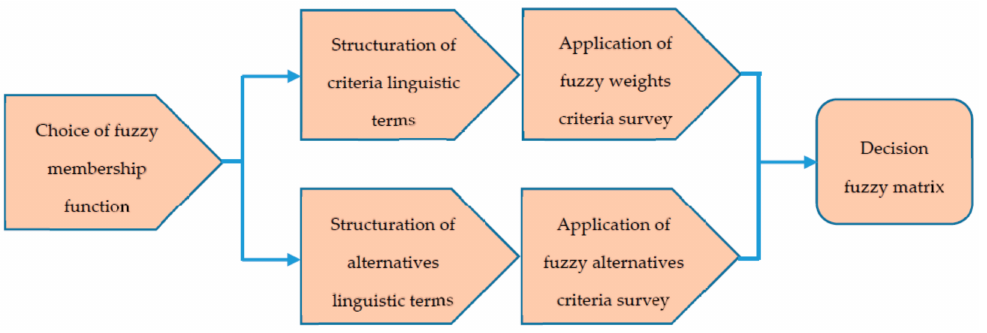
Figure 6. Decision fuzzy matrix.